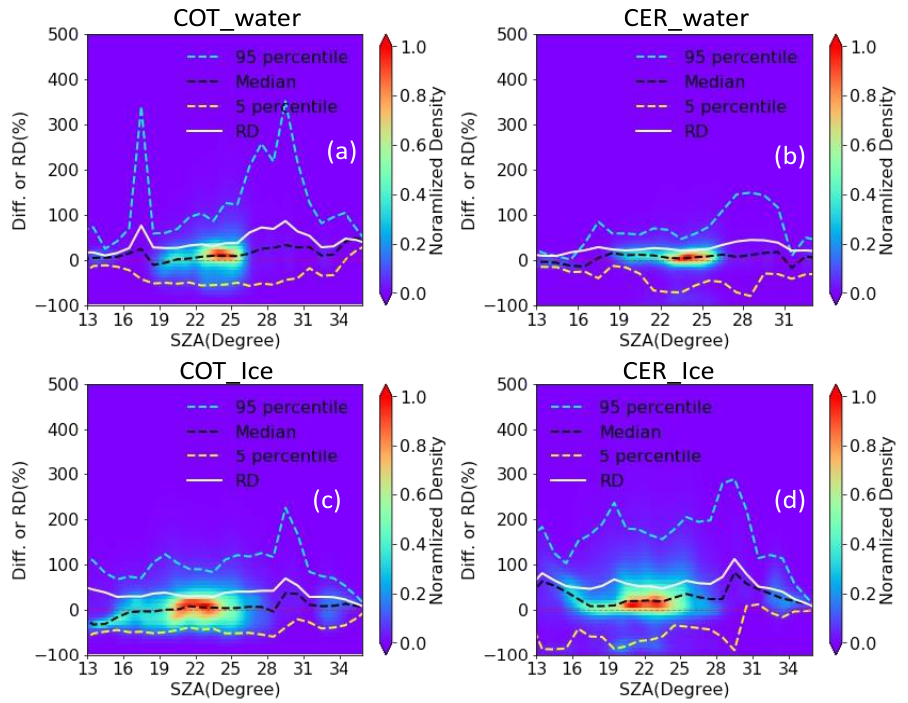
Figure 6. Statistical analyses (95 percentile, mean, 5 percentile, and RD values) of differences in ( a ) COT and ( b ) CER for water clouds and ( c ) COT and ( d ) CER for ice clouds between SGLI and MODIS for different values of solar zenith angle. For detail, see text.